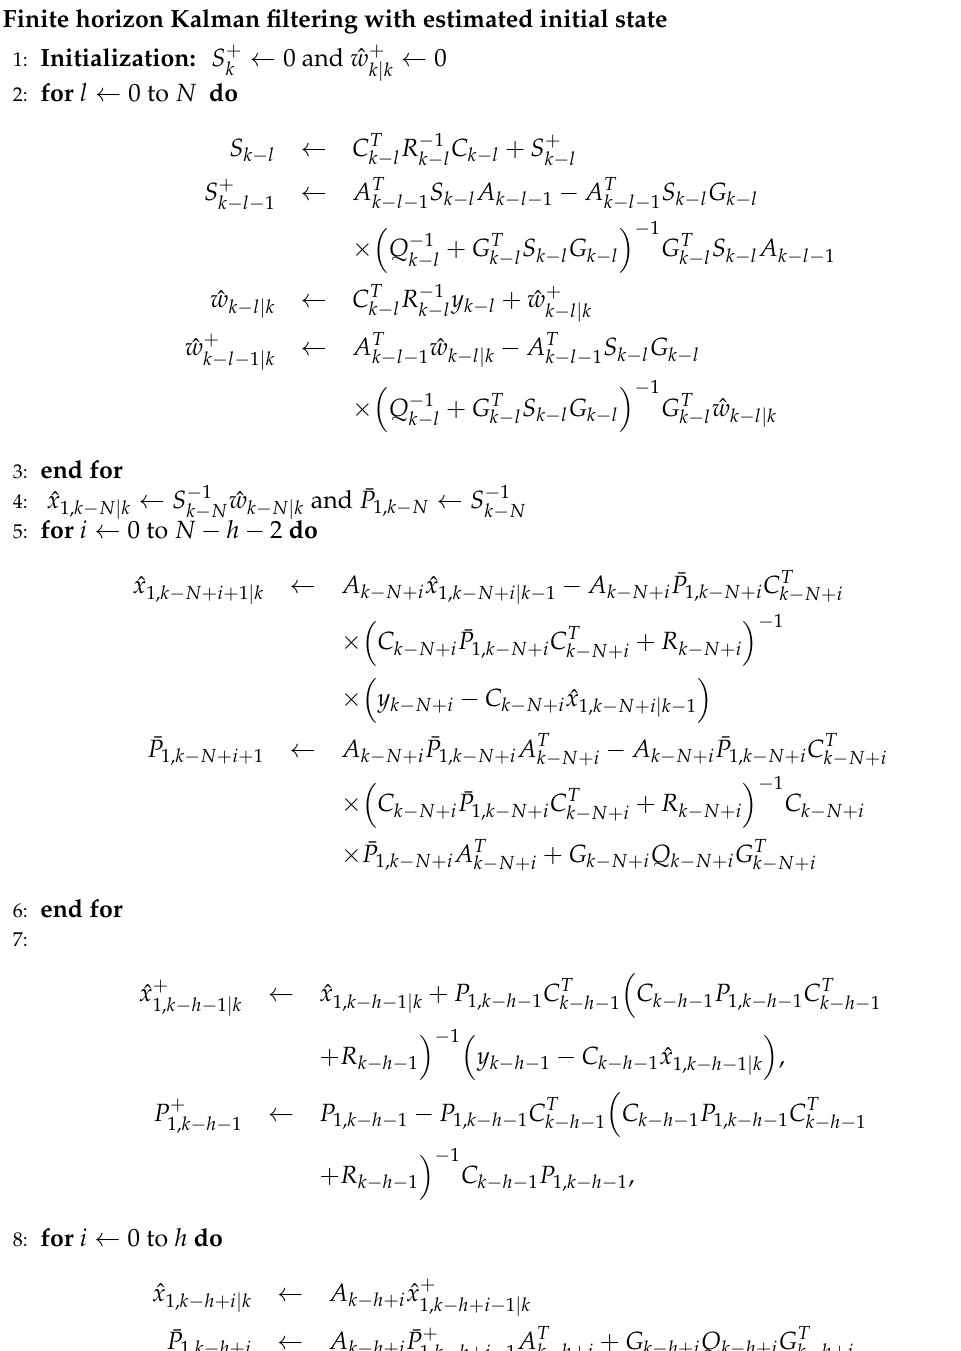
Algorithm 2 RHRTSF smoothing algorithm on the horizon [ k − N k ]